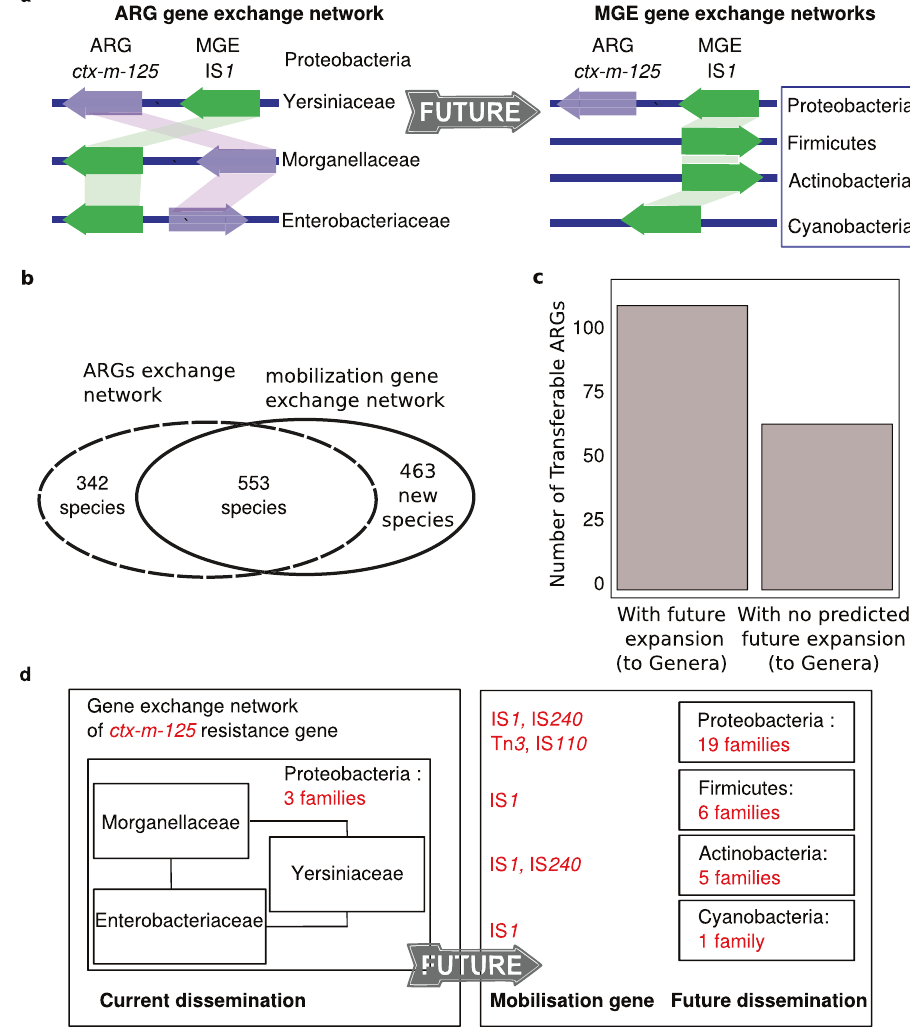
Fig. 3 Predicted transfer of antibiotic resistance genes (ARGs) to new bacterial families. a Conceptual guide: Left, the ARG gene exchange network, including neighbouring mobilisation contexts and phylogenetic information of the genomes. Right, ARG-associated mobile genetic element (MGE) and gene exchange network; blue-bordered boxes highlight probable phyla where ARGs may reach a new bacterial family in the future. b Difference and overlap of species in MGE and ARG GENs. c Number of transferable ARGs with potential future expansion to other genera through their MGE GEN. d Example: the ctx-m-125 gene, observed in three families and expected to reach 31 new families using different MGEs. The gray arrow highlights the prediction of the ctx- m-125 dissemination potential from its current dissemination. Boxes show future expansion of ctx-m-125 by number of families within a phylum. Source data are provided in Supplementary Data 1, 3, 5, and